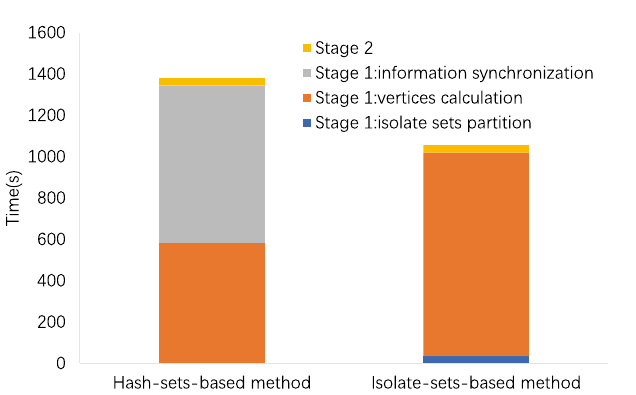
Figure 3. Time breakdown on dataset LiveJournal. The time occupation of isolate sets partition is about 3.3% with 17 iterations, and the time of information synchronization is about